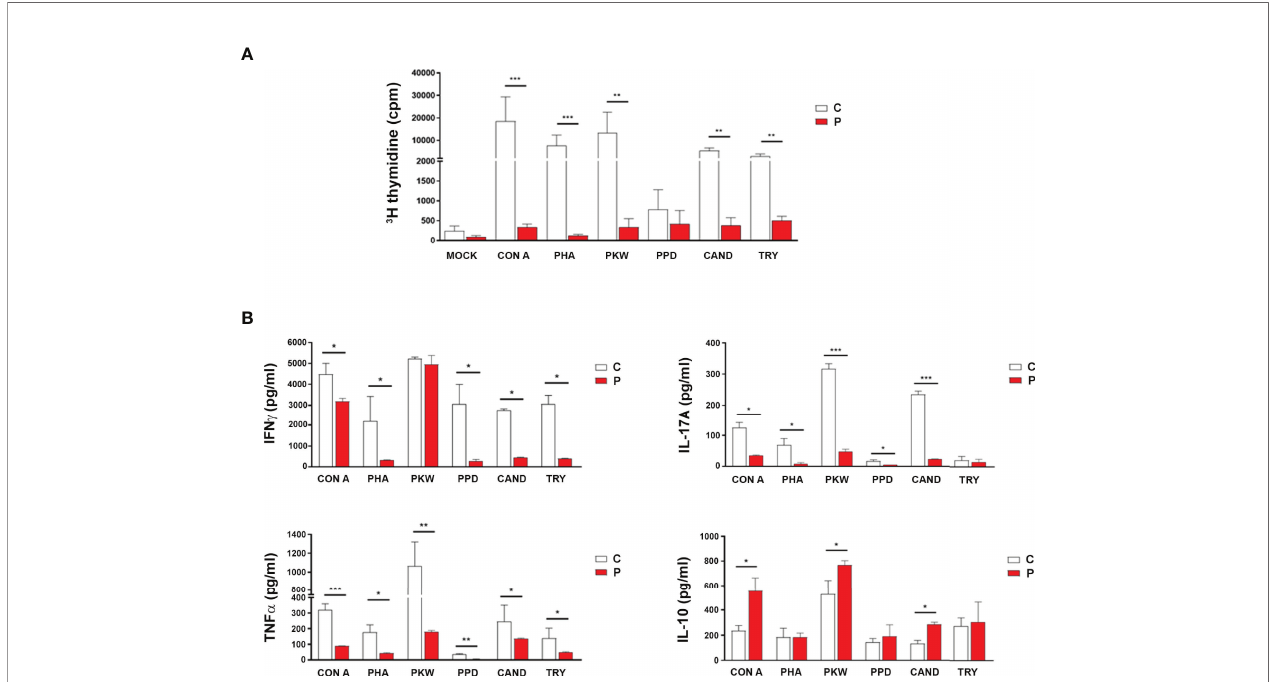
FIGURE 2 | Functional analysis of cellular adaptive immune compartment . (A) Lymphoproliferative responses of peripheral blood mononuclear cells (PBMC) from the patient (P) and control (C) individuals to different mitogenic stimuli [concanavalin A (Con A), phytohemagglutinin (PHA), Pokeweed (PKW), candidin, and antigens of Mycobacterium tuberculosis or Trychophyton spp.] or medium alone (mock). Cells were cultured (3.0x10 5 /well) in quadruplicate for each condition and incubated for 96 h at 37°C/5% CO 2 as previously described (33). During the last 18 h of culture, wells were pulsed with 1 µCi of [methyl-3H] thymidine in fresh medium. Cells were harvested onto glass fi ber fi lters and labeled material was counted in a b scintillation counter. Results were expressed as counts per minute (cpm). (B) IFN g , IL-17A, TNF- a and IL-10 concentrations in PBMCs culture supernatants determined by sandwich ELISA and results expressed as pg/ml. Experiments were performed at least in quadruplicate and repeated twice with similar results. Data are shown as mean ± SEM, the patient and sex and age-matched control individuals (n=6 healthy females, aged 3-7 years old). Red bars correspond to the average values of the patient and white bars correspond to the average values of the controls analyzed. Mann-Whitney test; * p < 0.05, ** p < 0.01 and *** p <